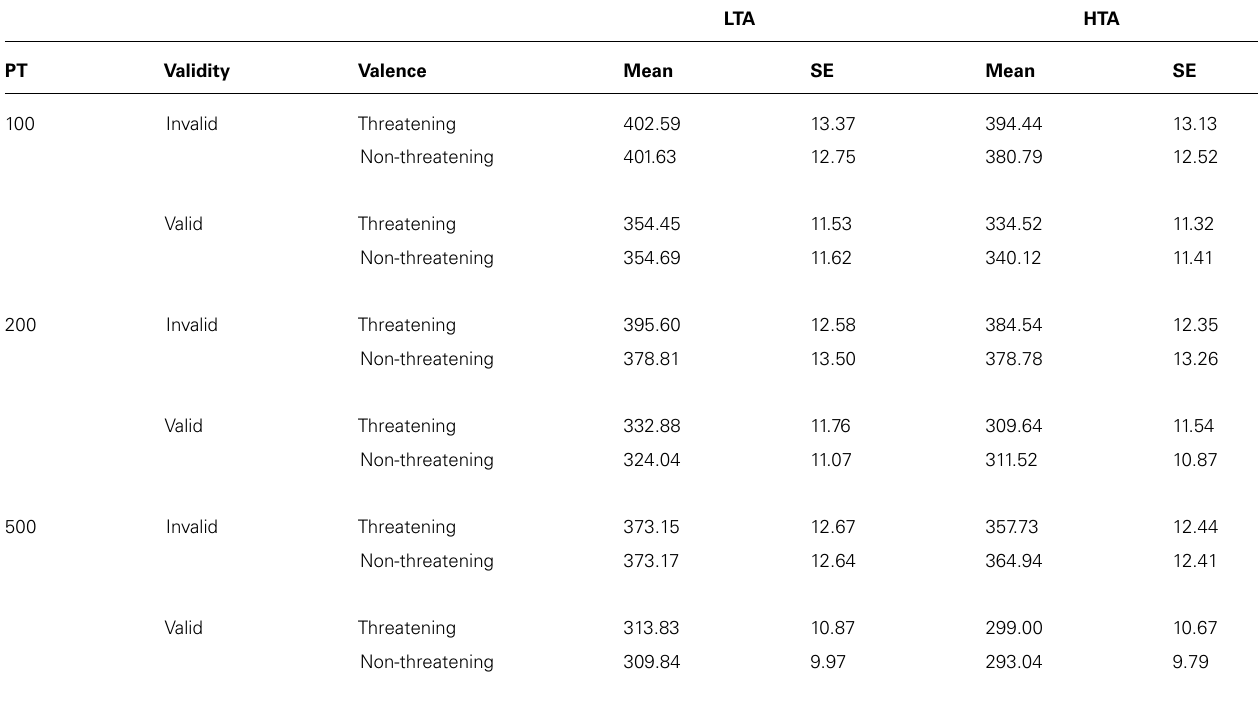
Table 1 | Mean and SE of the RTs in the Modified PosnerTask as a function of anxiety group, validity, valence, and